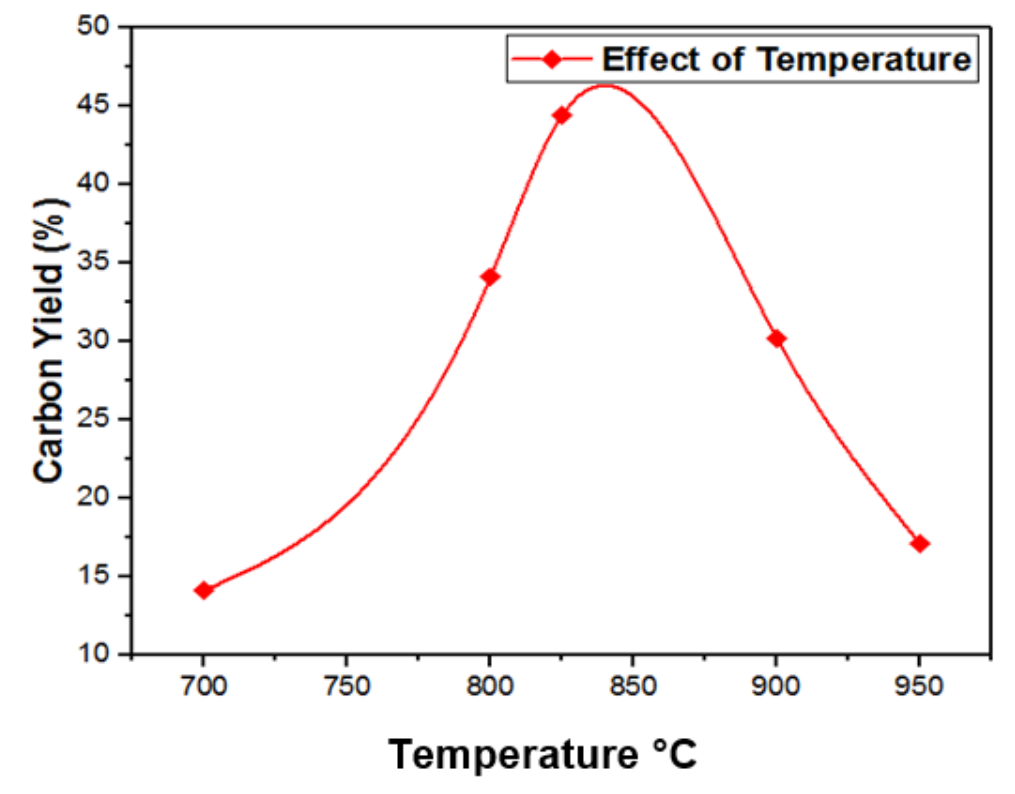
Figure 6. Changes in percent carbon yield with change in temperature.